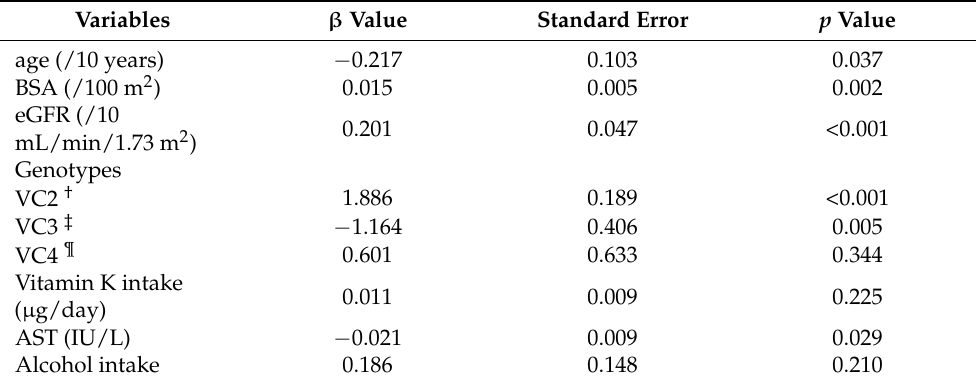
Table 4. Factors affecting the warfarin maintenance dose in multiple linear regression